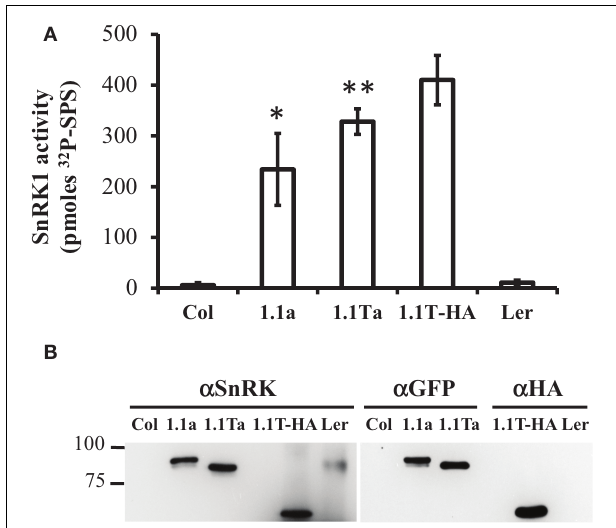
FIGURE 7 | SnRK1 activity in Transgenic Plants. (A) SnRK1 proeins were immunoprecipitated as described in the Materials and Methods, and kinase assays were performed. Means of 3 triplicate reactions ± SD are presented. ∗∗ p -value ≤ 0.01, and ∗ indicates a p -value less than 0.05 as compared to the 1.1T-HA sample. (B) An equal amount of sample was detected by western analysis with anti-SnRK, anti-GFP, or anti-HA